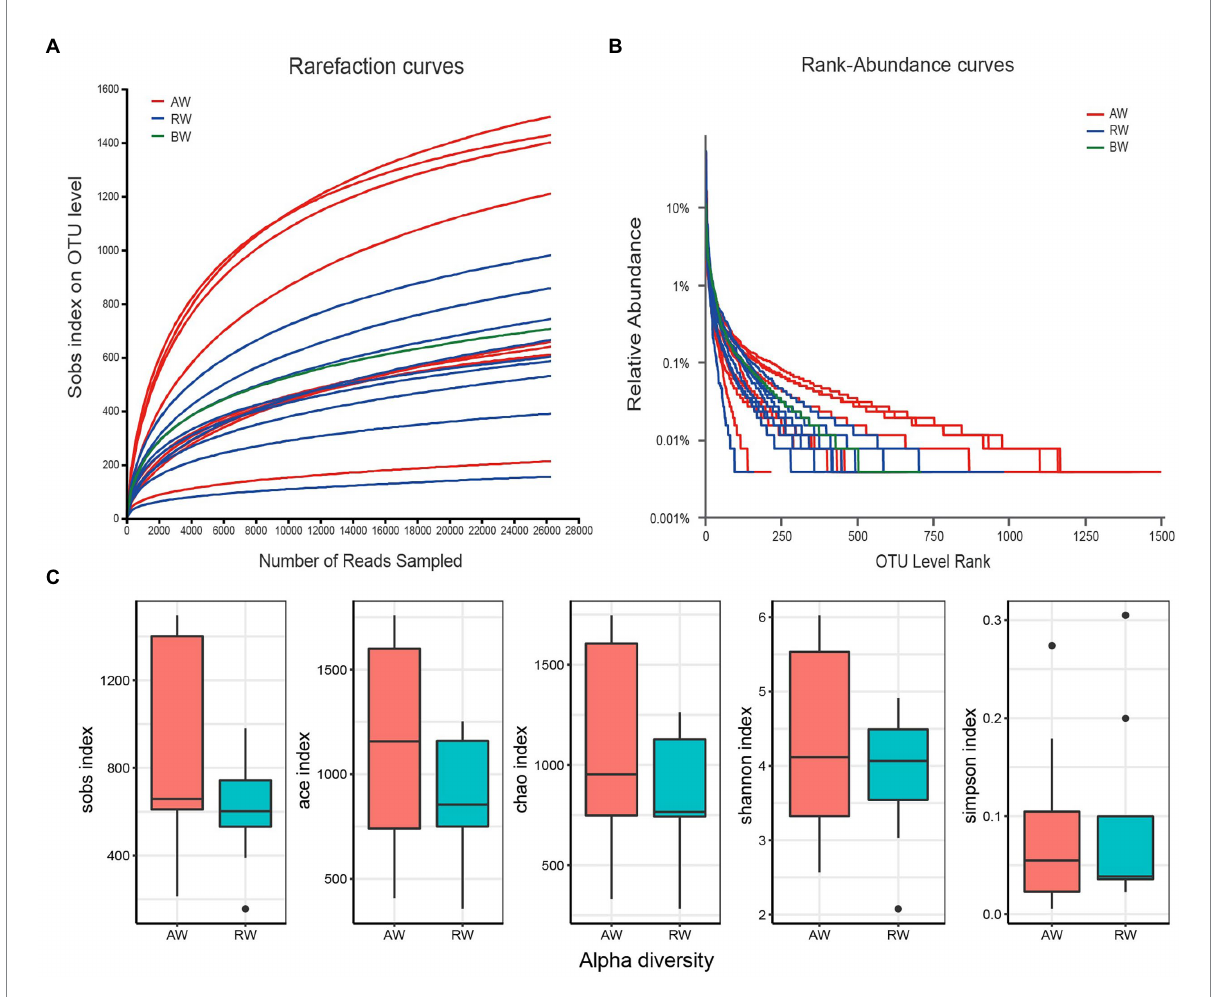
FIGURE 3 (A) Rarefaction curves at different sequencing depths. The horizontal axis represents the amount of randomly sampled sequencing data and the vertical axis represents the number of observed taxa (i.e., Sobs). “BW” represents background sample. (B) Relative abundance of the ranking OTU sequences in the groundwater samples. (C) Distribution boxplot of the alpha diversity index among two